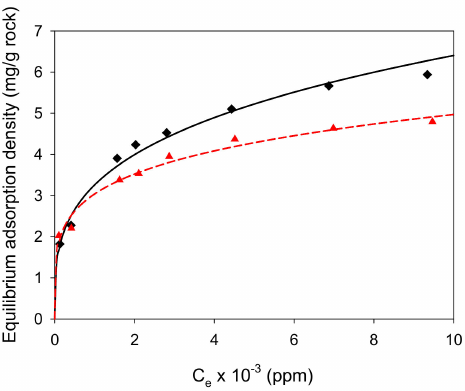
Figure 7. Freundlich isotherm fit for the adsorption of AOT and the AOT + PEG-600 eutectic. Dots represent experimental data for: Figure 1. Melting curves of the systems AOT + PEG: ● AOT + PEG-2000, ▲ AOT + PEG-1000, ◆ AOT AOT and (cid:78) eutectic. Black, solid line and red, dashed line + PEG-600. represent the Freundlich isotherm fit for AOT and the eutectic mixture, respectively.